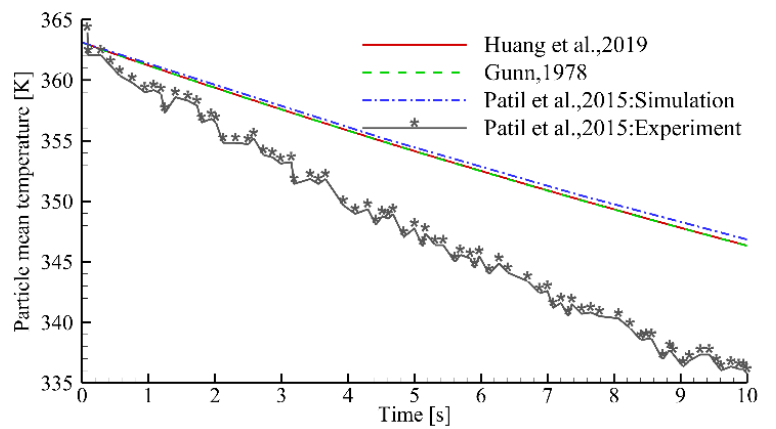
Figure 3. Variations in the local solid volume fraction ( a ) and mean particle Reynolds number ( b ) against flow time.